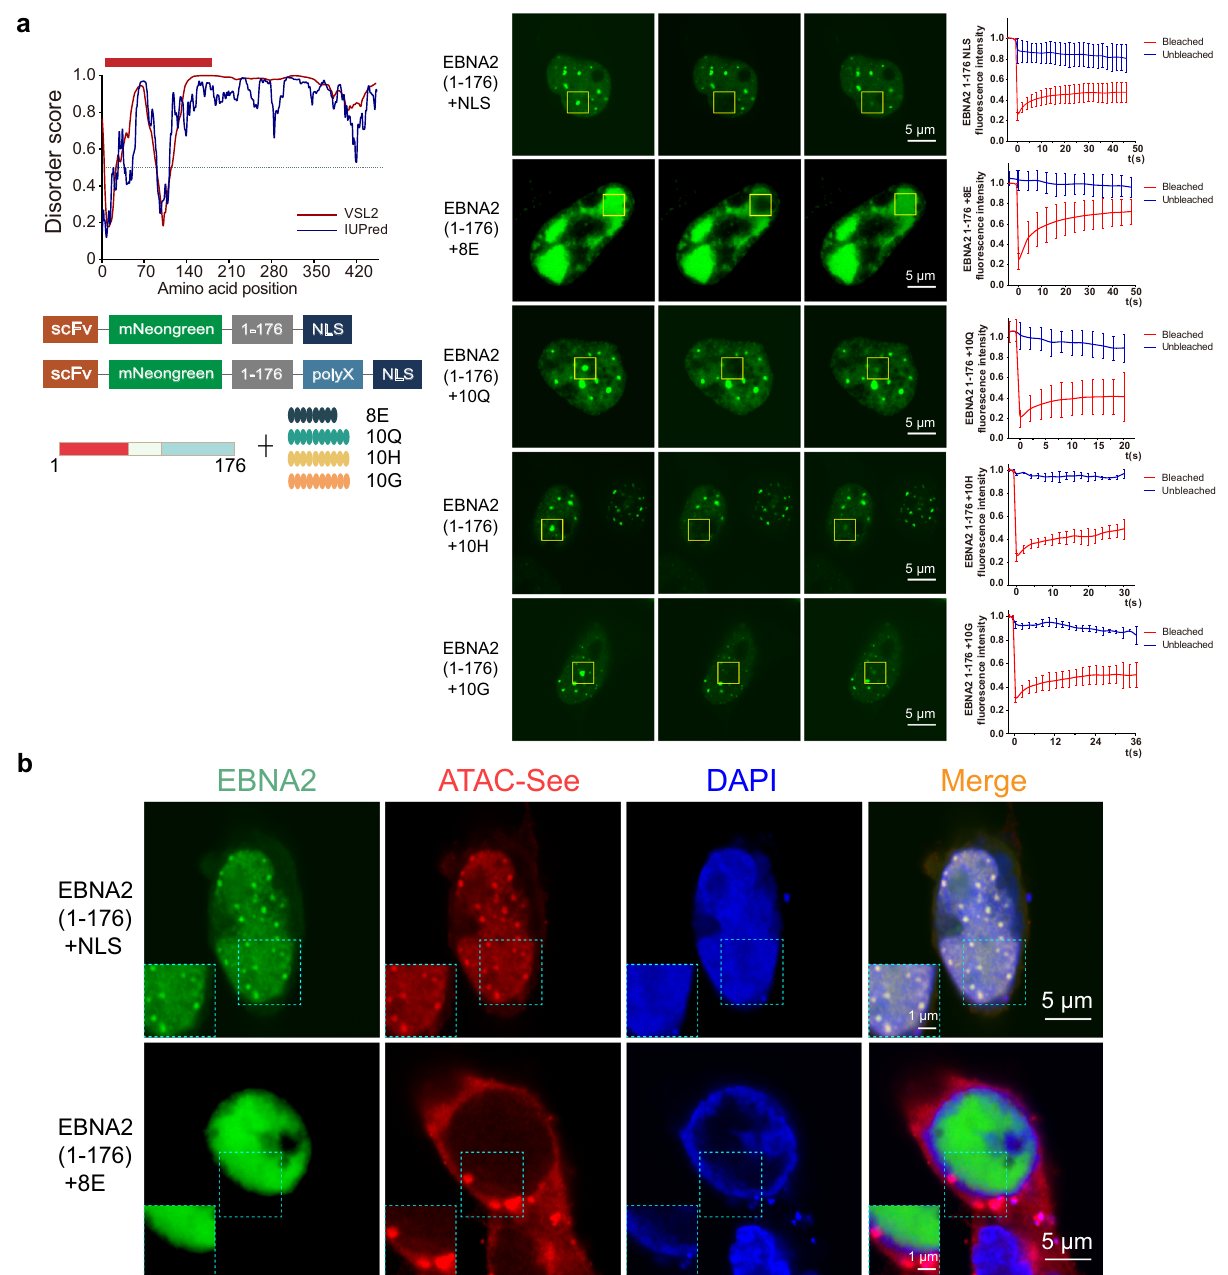
Fig. 5 The N-terminal of EBNA2 is necessary and suf fi cient to induce ACDs. a Immuno fl uorescence images of the polyX-modi fi ed EBNA2 N-terminal. Graphs plotting intrinsic disorder analysis for EBNA2 and the design of the polyX-modi fi ed EBNA2 N-terminal (left). The sequence (amino acid from 1 to 176) cloned for subsequent experiments is highlighted with a red bar. Below is a schematic diagram of the polyX-modi fi ed EBNA2 N-terminal. FRAP recovery images of the EBNA2(1-176), EBNA2(1-176) + 8E, EBNA2(1-176) + 10Q, EBNA2(1-176) + 10H, and EBNA2(1-176) + 10G condensates (middle). The yellow box highlights the condensate before, during, and after photobleaching. Data are plotted (right) as SD ( n = 3). Scale bars, 5 μ m. b Representative images show the colocalization of the accessible chromatin domains and mNeonGreen-EBNA2(1-176) (top) or mNeonGreen-EBNA2(1- 176) + 8E (bottom) condensates. The experiment was repeated three times independently with similar results. Scale bars, 5 μ m. Magni fi ed regions, scale bars, 1 μ + 10H and glycine expansions + 10G, single stranded oligonucleotides encoding the respective amino acid expansions were inserted into the pCAG-scFv-mNeon- Green-EBNA2(1-176)-NLS using Gibson assembly. For the generation of the amino acid expansions-NLS, the primer pairs are as follow: SV40-NLS F: 5 ′ -gaa- gaagaagaagaagaagaagaagaagaaggtggtggtagcggtggtgg-3 ′ , SV40 NLS R: 5 ′ -agcgagctc tagcccgggcgtcgactcacaccttgcgcttcttcttgggactagtacc-3 ′ . + 8E SV40-NLS F: 5 ′ -gaagaa- gaagaagaagaagaagaaggtggtggtagcggtggtgg-3 ′ , EBNA2(1-176) + 8E-NLS F: 5 ′ - CCCCTCTGCCACCTGCAACAgaagaagaagaagaagaagaagaagaagaa-3 ′ and SV40 NLS R: 5 ′ -agcgagctctagcccgggcgtcgactcacaccttgcgcttcttcttgggactagtacc-3 ′ . + 10Q